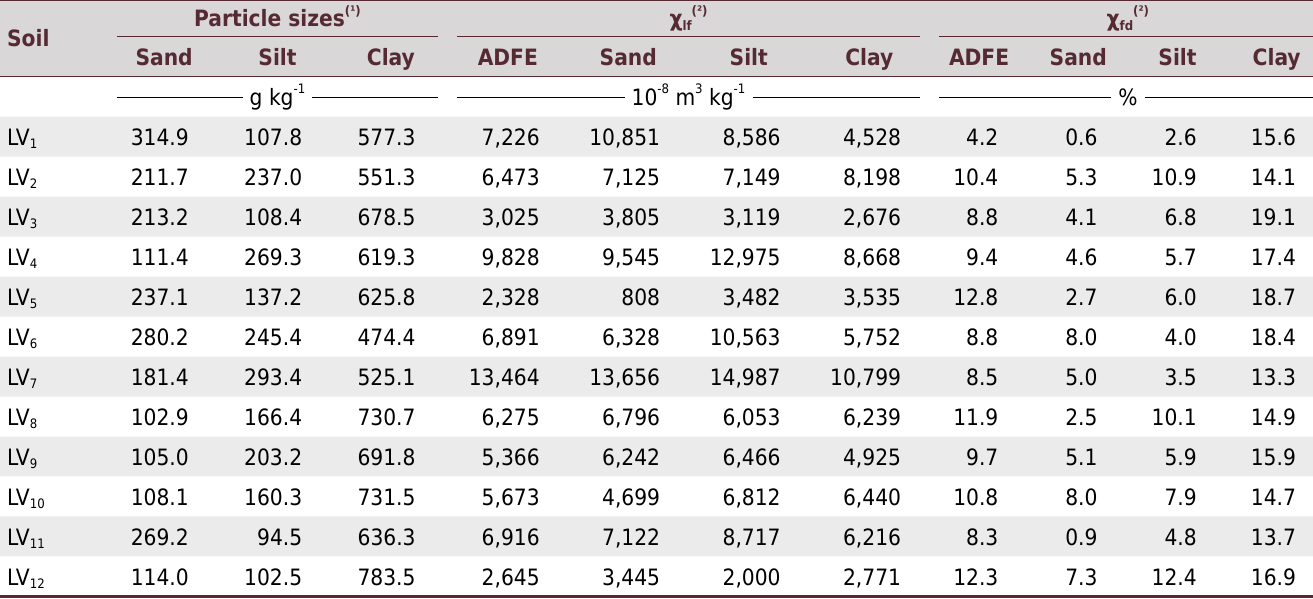
Table 5. Particle size proportion, and magnetic susceptibility (χ lf ) and dependent frequency (χ fd ) in ADFE, sand, silt, and clay fractions Soil